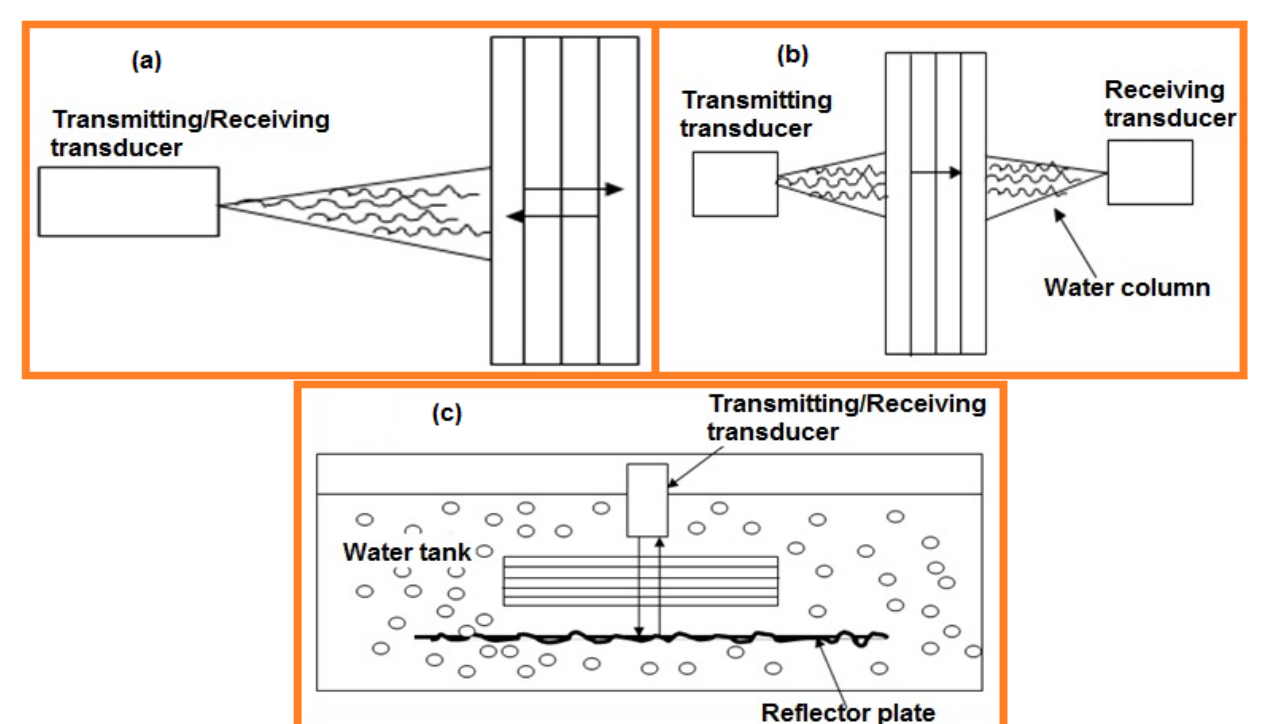
Figure 10. Schematic representation of experimental setup ( a ) pulse-echo inspection, ( b ) through transmission testing, and ( c ) immersion testing.